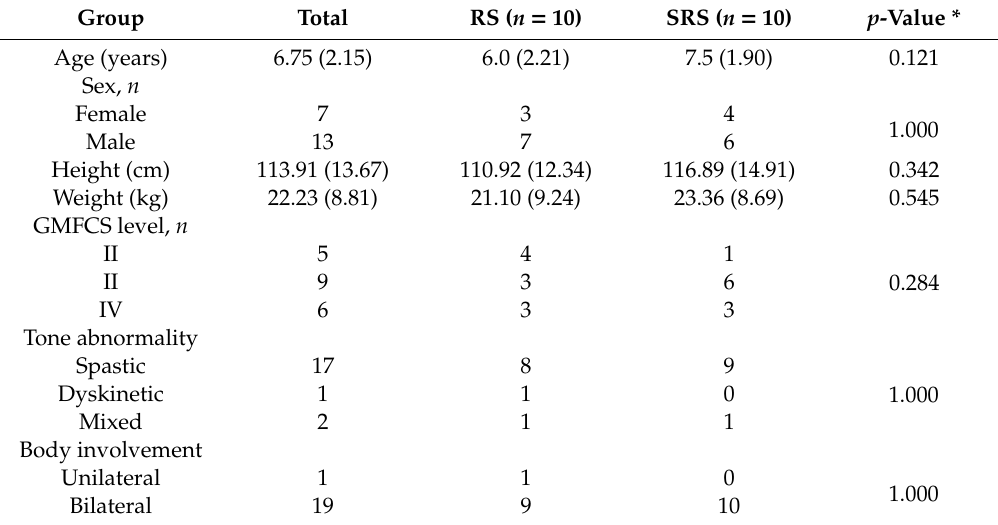
Table 1. Demographic characteristics of the participants.